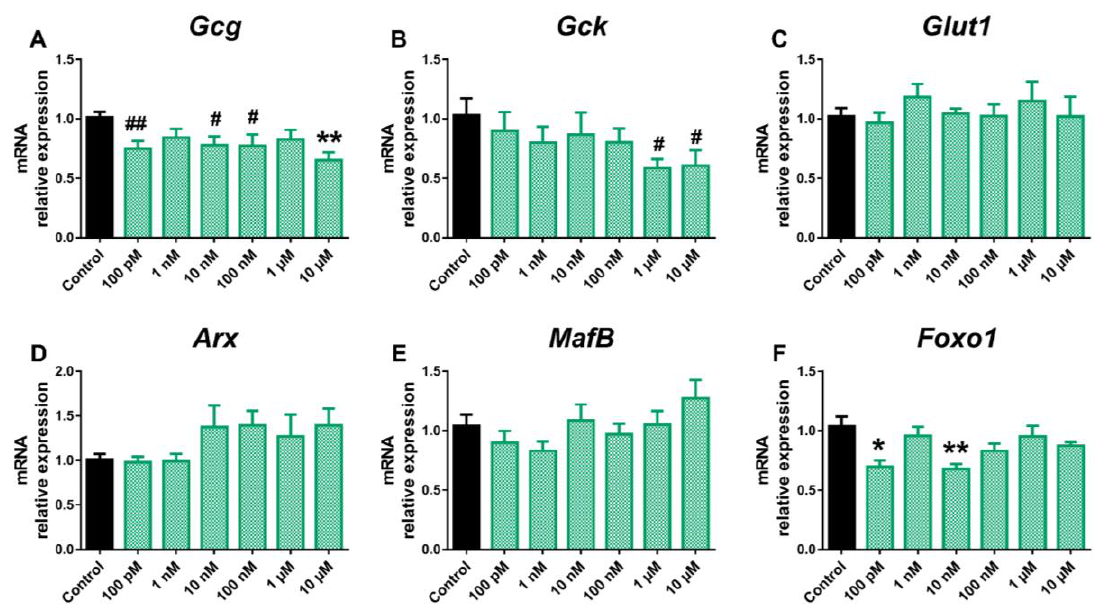
Figure 3. BPS effects on the expression of genes involved in pancreatic α -cell function and identity. mRNA expression of ( A ) Gcg , ( B ) Gck , ( C ) Glut1 , ( D ) Arx , ( E ) MafB , and ( F ) Foxo1 was measured in α TC1-9 cells treated for 24 h with different BPS concentrations (100 pM–10 µ M). Data are represented as mean ± SEM of n = 3–4 independent experiments. * vs. Control; * p < 0.05, ** p < 0.01 by one-way ANOVA followed by Dunnett’s post hoc test or Kruskal–Wallis followed by Dunn’s post hoc test. # vs. Control; # p < 0.05, ## p < 0.01 by the Student’s t test.